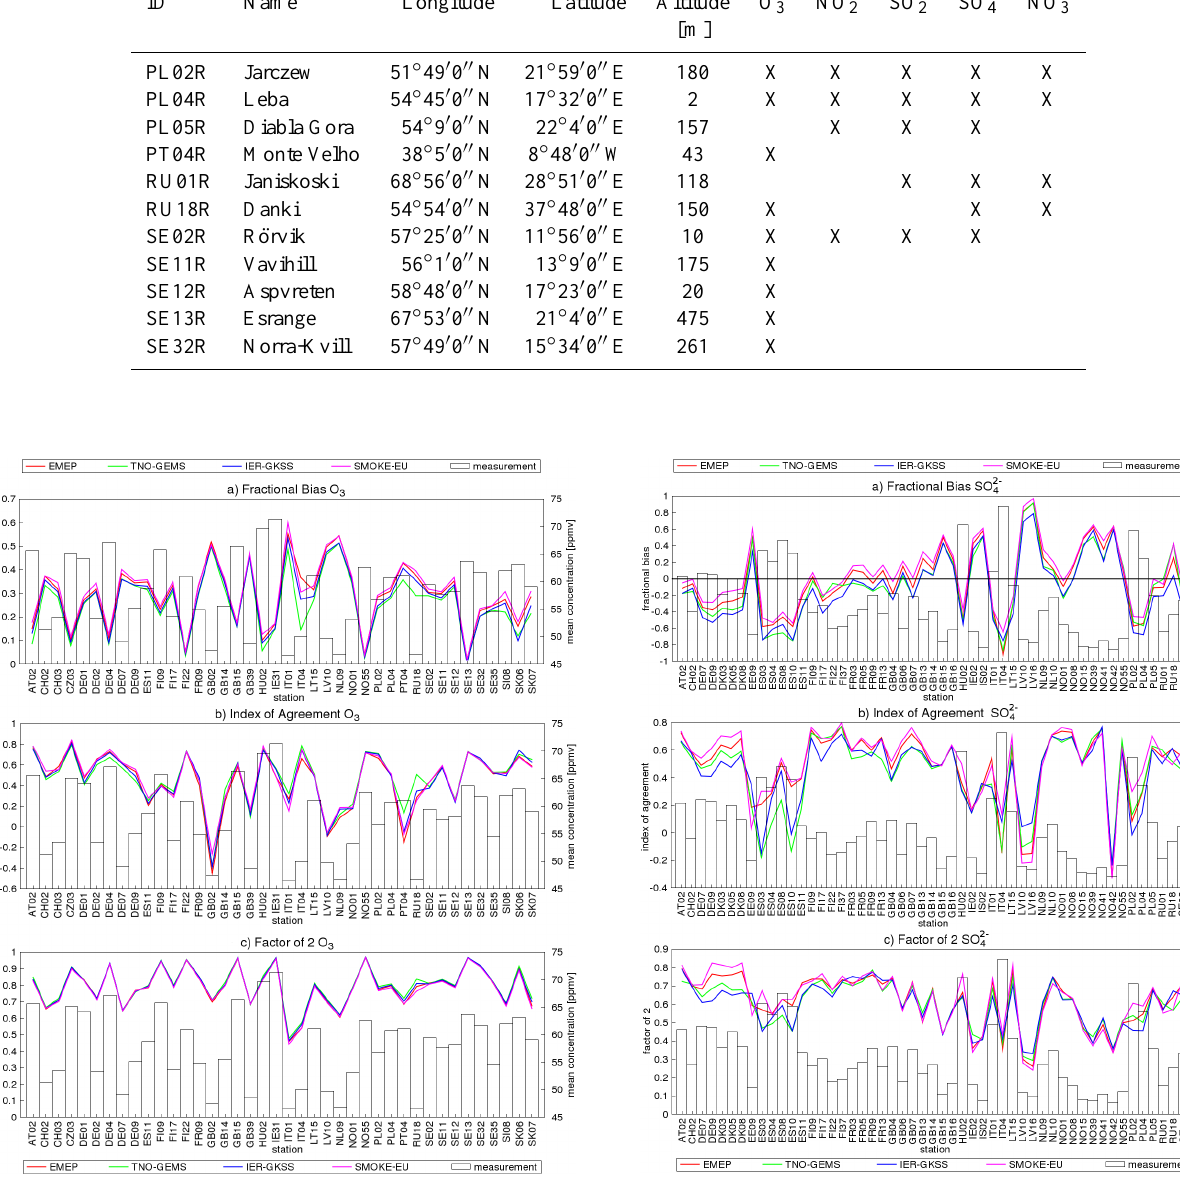
Fig. 13. Comparison of modelled O 3 concentrations using four different emission datasets with hourly observations from 40 rural EMEP measurement sites ( N =329197) for the year 2000 (see also Tables 6 and 7). (a) Fractional bias (b) index of agreement (c) relative amount of values within a factor of 2 (1=100%).